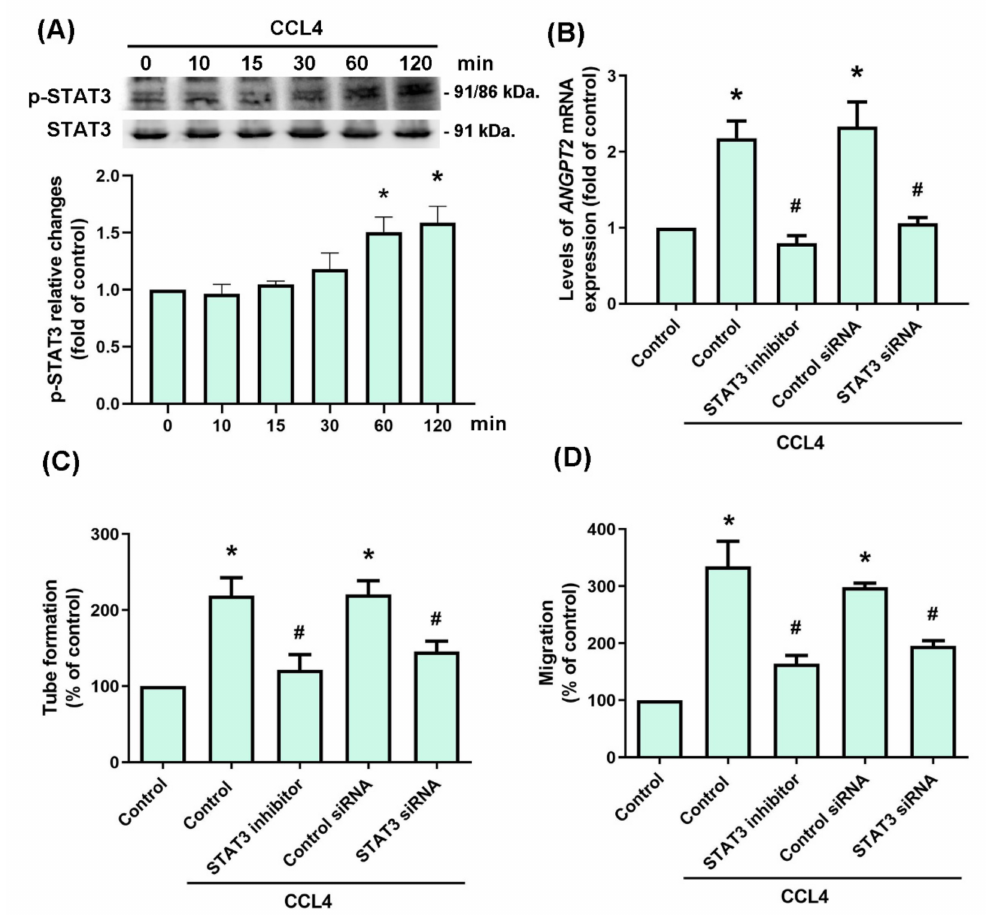
Figure 5. STAT3 activation was involved in CCL4-induced promotion of Angpt2 expression and angiogenesis. ( A ) SCC4 cells were incubated with CCL4 (30 µ g/mL) for the indicated time intervals, before STAT3 activation was examined by Western blot. ( B ) SCC4 cells were treated with a STAT3 inhibitor (10 µ M) or transfected with a STAT3 siRNA, then stimulated with CCL4 (30 µ g/mL) for 24 h. Levels of ANGPT2 mRNA were examined by qPCR. ( C ) SCC4 cells were treated with a STAT3 inhibitor (10 µ M) or transfected with a STAT3 siRNA, then stimulated with CCL4 (30 µ g/mL) for 24 h. CM was applied to EPCs for 16 h. Capillary-like structure formation was examined by the tube formation assay. ( D ) SCC4 cells were treated with a STAT3 inhibitor (10 µ M) or transfected with a STAT3 siRNA, then stimulated with CCL4 (30 µ g/mL) for 24 h. CM was applied to EPCs for 24 h. EPC migratory ability was examined by the Transwell migration assay. Each experiment was performed three times. * p < 0.05 compared with controls; # p < 0.05 compared with the CCL-treated group (30 µ